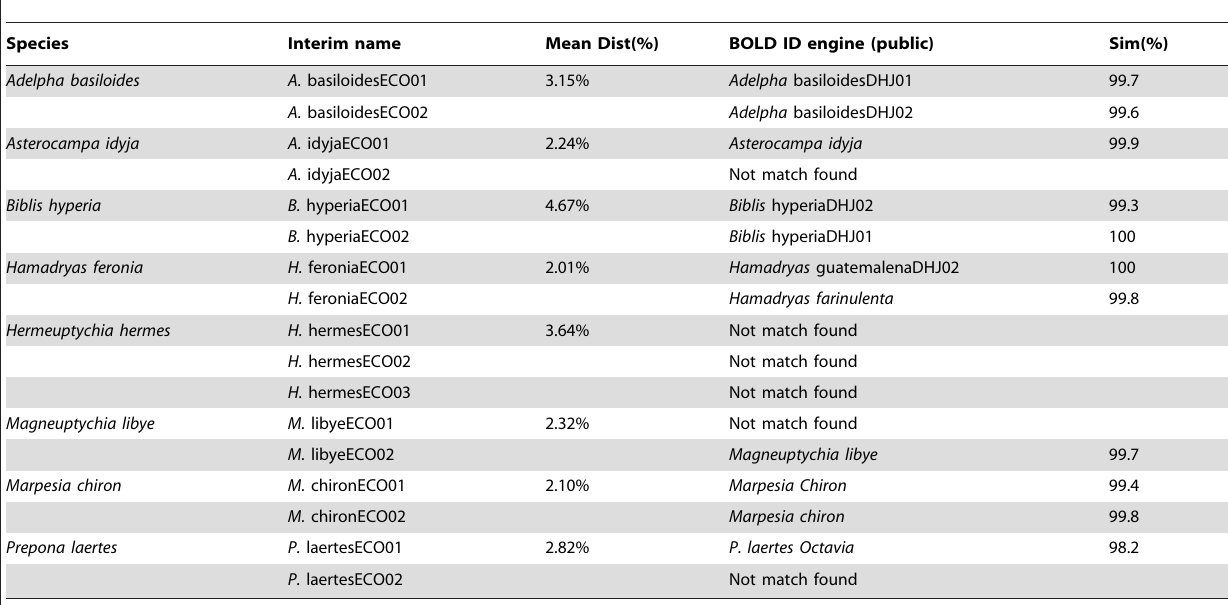
Table 1. Eight species of Nymphalidae from the Yucatan Peninsula which include two or three clusters of barcode sequences showing . 2% sequence